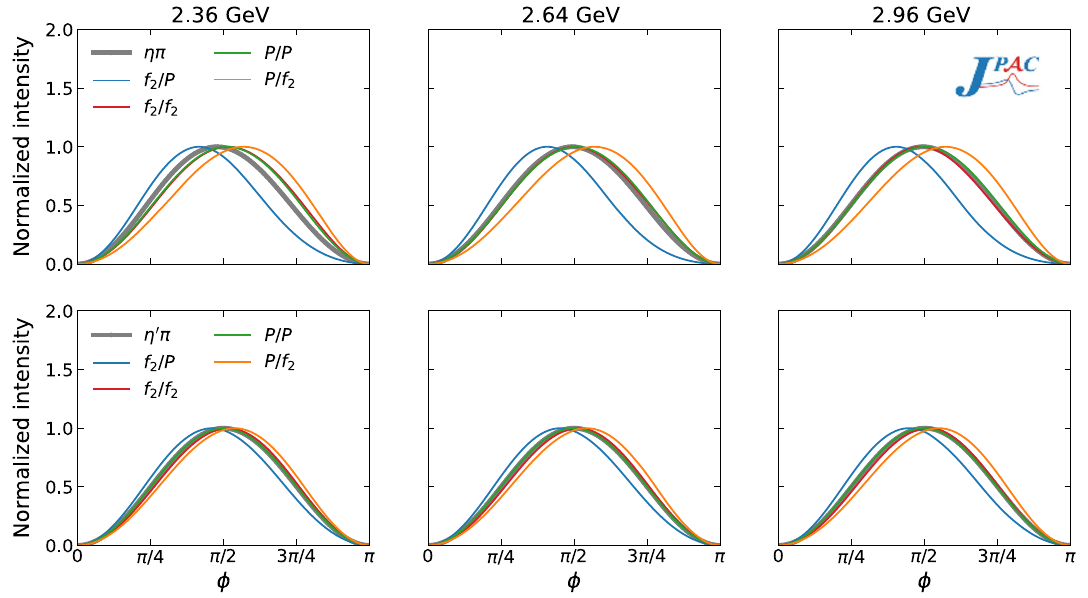
Fig. 10 Intensity distribution of φ from MVR (grey), for three fixed energies and cos θ = − 0 . 866 (close to the backward peak) for ηπ (upper row) and η (cid:2) π (lower row) compared to the same distributions